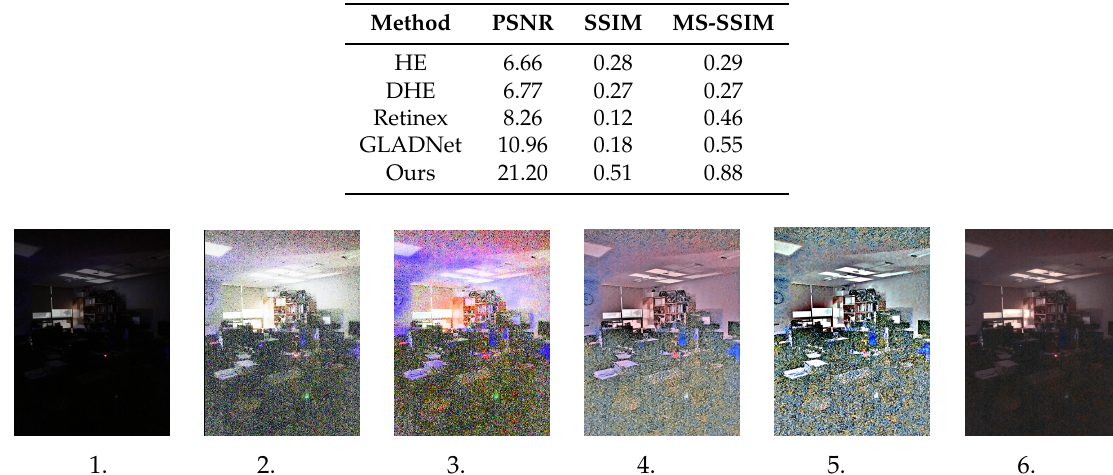
Figure 5. Extreme low-light indoor image results, from first (left) to last (right): 1. input image, 2. HE [25], 3. DHE [26], 4. Retinex [28], 5. GLADNet [31], and 6. our proposed